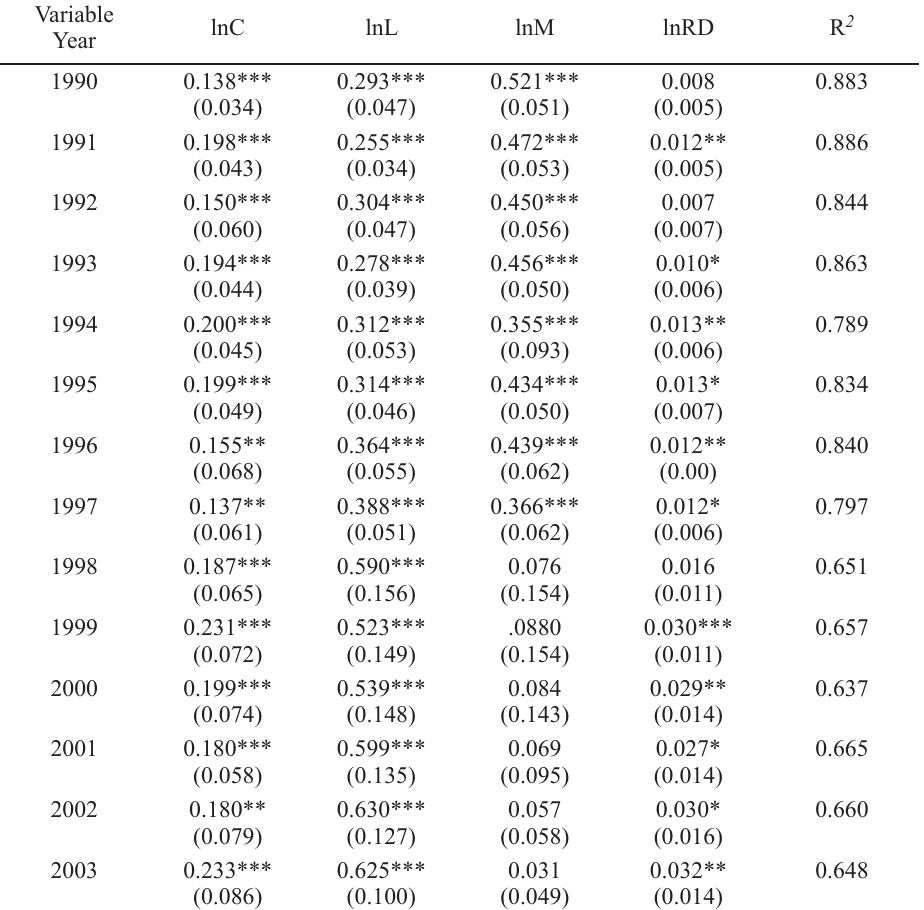
Table 5. Taiwan’s R&D productivity, year by